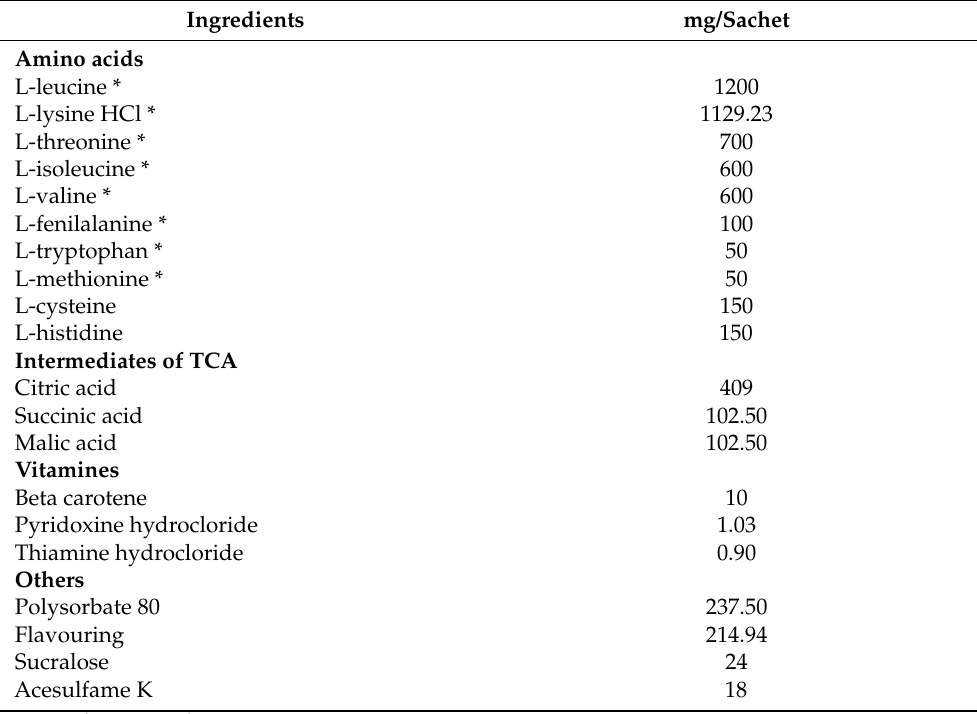
Table 1. Composition of the mixture used in the current study.